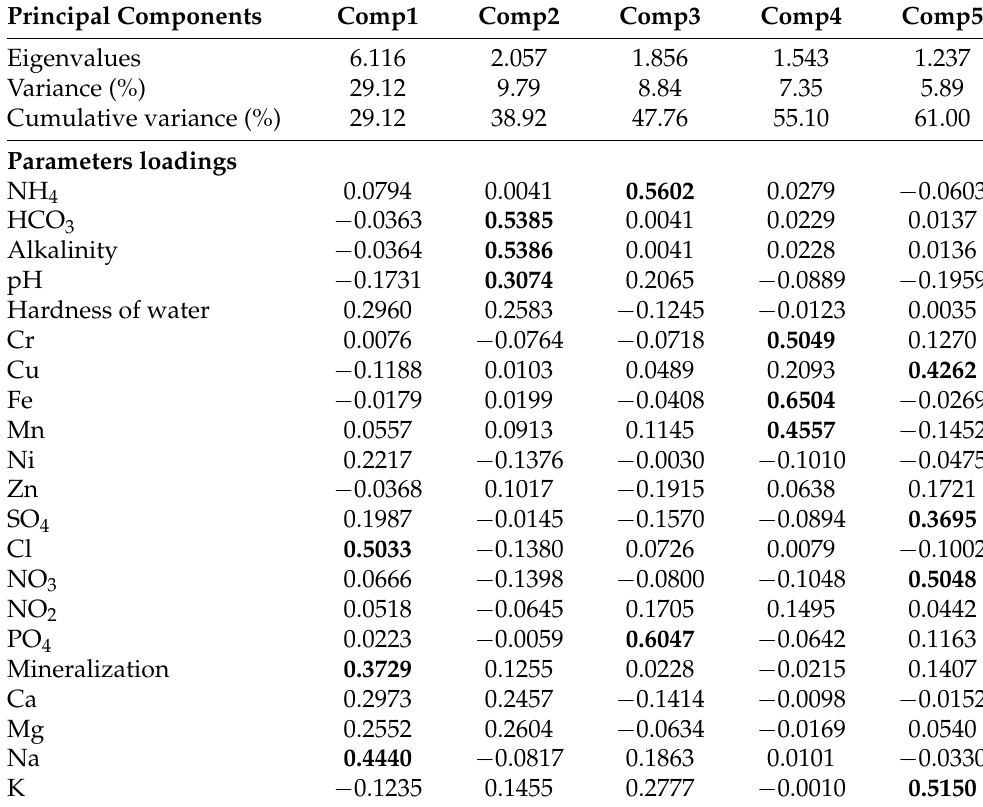
Table 1. Chemical components loading attributed to each PCs based on the PCA with Varimax